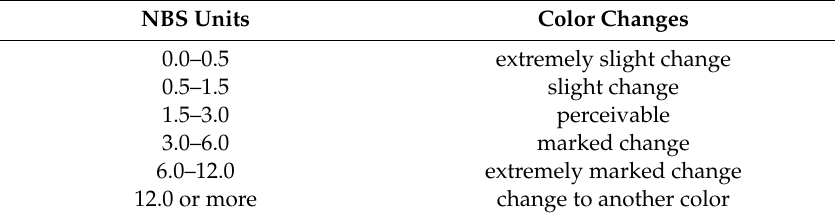
Table 3. Levels of color change, according to the national bureau of standards